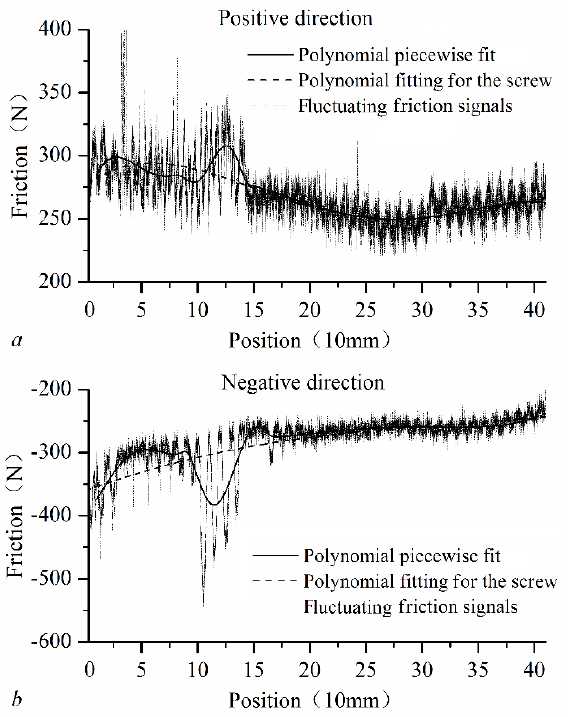
Figure 6. Comparison of the estimated friction with IAFVs. ( a ) Position direction; ( b ) Negative direction.